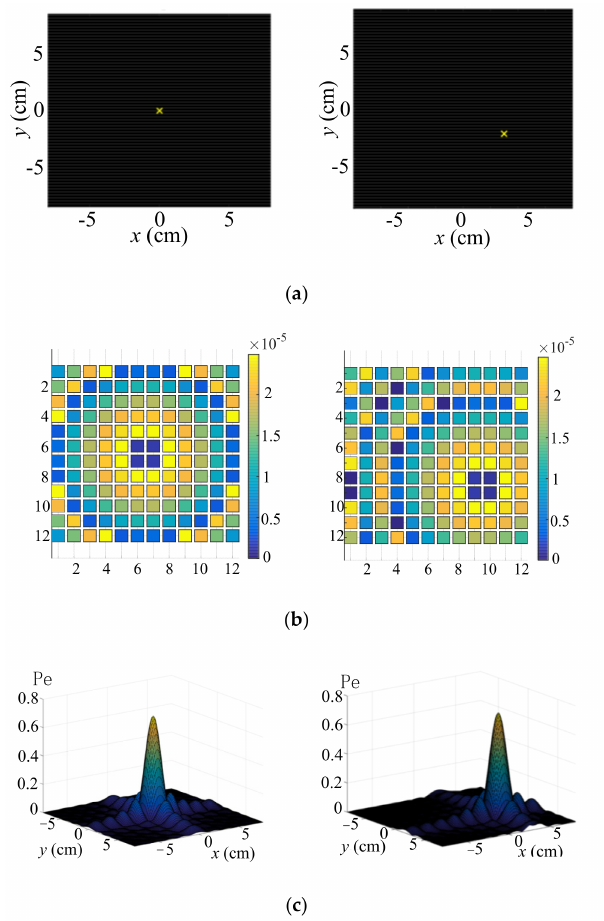
Figure 2. Simulation of single focal point. ( a , b ) are the phase difference distribution of each transducer. ( c ) is the normalized ultrasound pressure